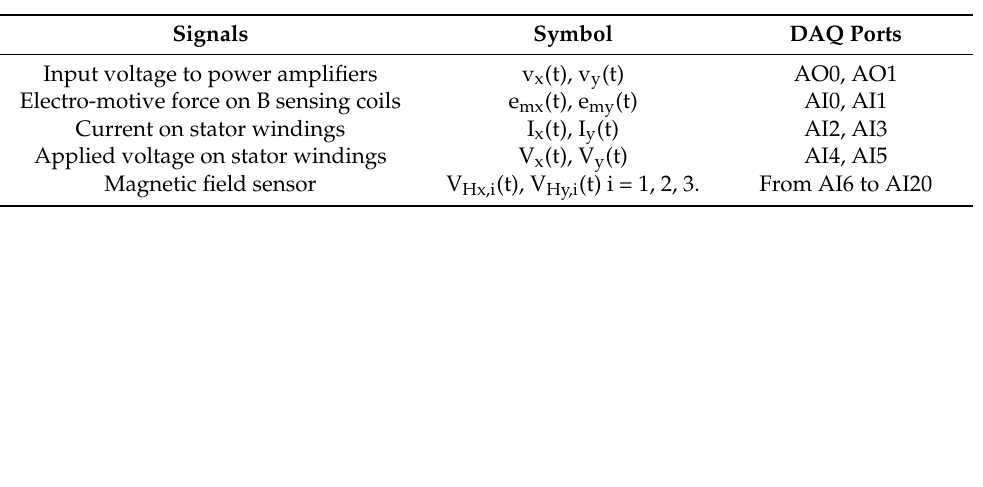
Table 2. Instrumentation adopted in the SDT testing frame: apparatuses and corresponding models.